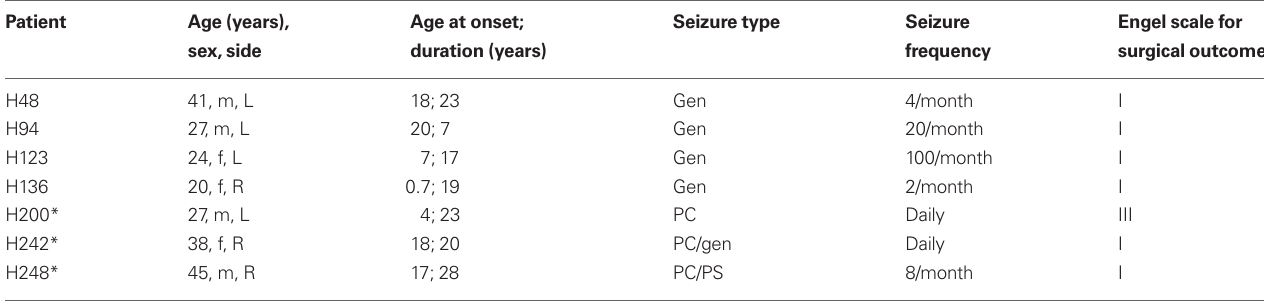
Table 1 | Summary of the clinical data from the epileptic patients and the outcome of surgery.